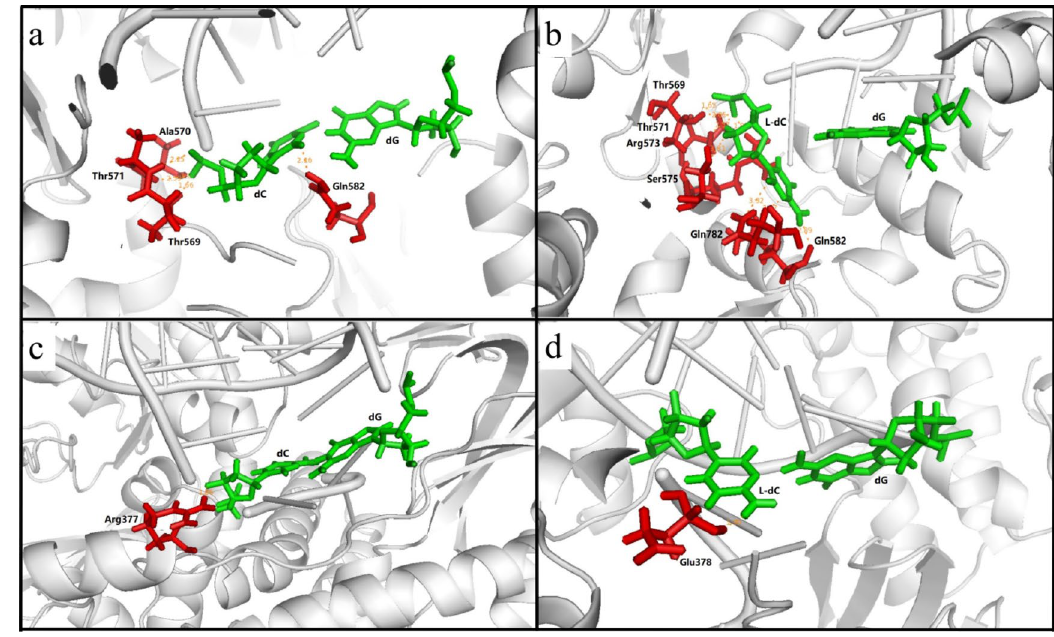
Figure 6. The cognate nucleotide insertion opposite to l-dC and dC by Taq DNA polymerase and Vent DNA polymerases. Taq DNA polymerase can bypass dC ( a ) but not bypass l-dC ( b ). Vent DNA polymerase can bypass not only dC ( c ) but also l-dC ( d ). Nucleotide pairs were shown in green, neighbouring amino acid residues were shown in